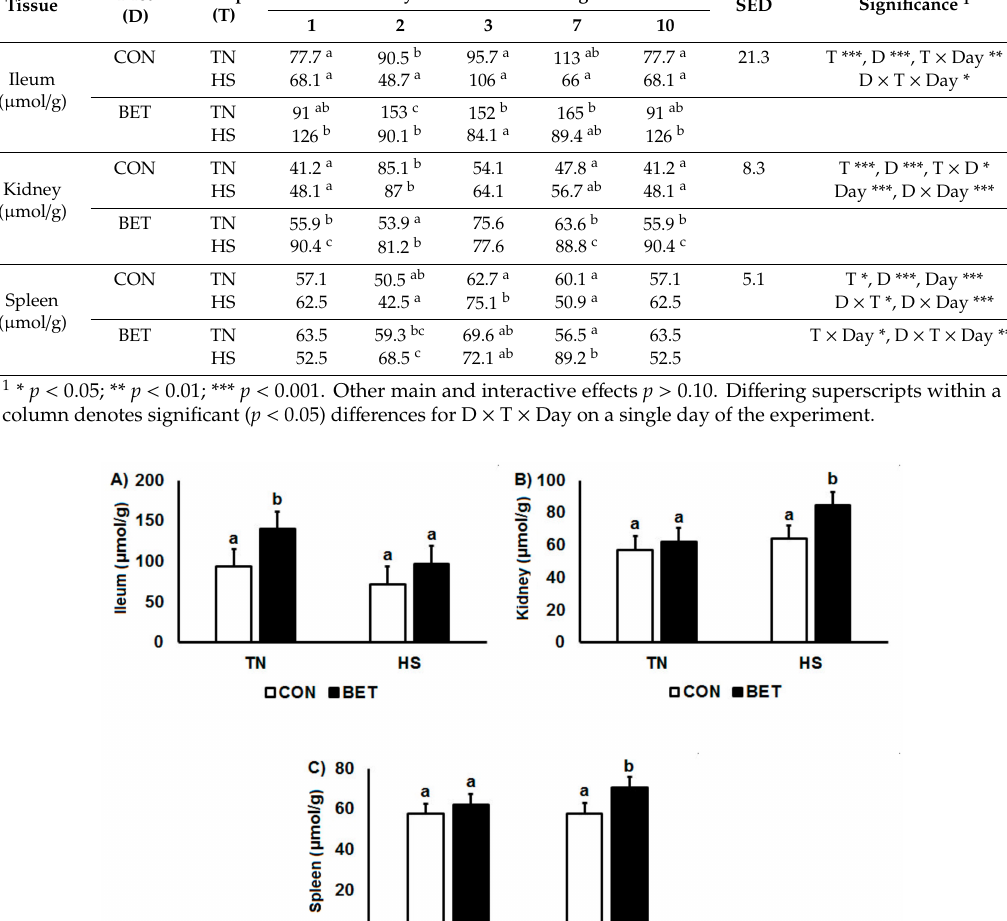
Table 3. E ff ects of a control diet (CON) or dietary betaine (BET) on tissue betaine concentration in broilers housed under thermoneutral (TN) or heat stress (HS) conditions for 1, 3, 7 and 10 days. Tissue